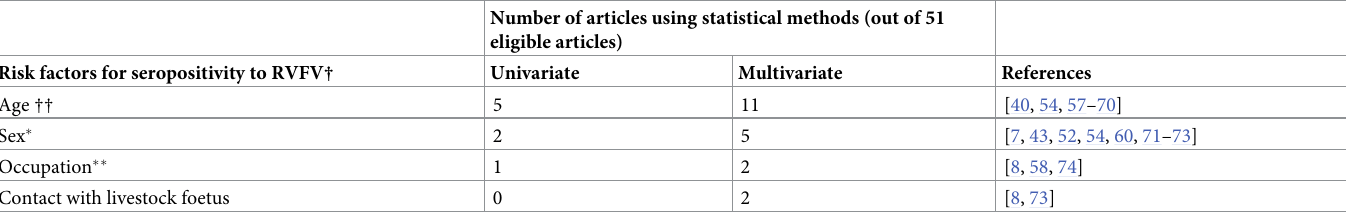
Table 2. Number of eligible articles in humans in Africa identifying potential risk factors as significantly associated with seropositivity for Rift Valley fever virus (RVFV) in final statistical model. Number of articles using statistical methods (out of 51 eligible